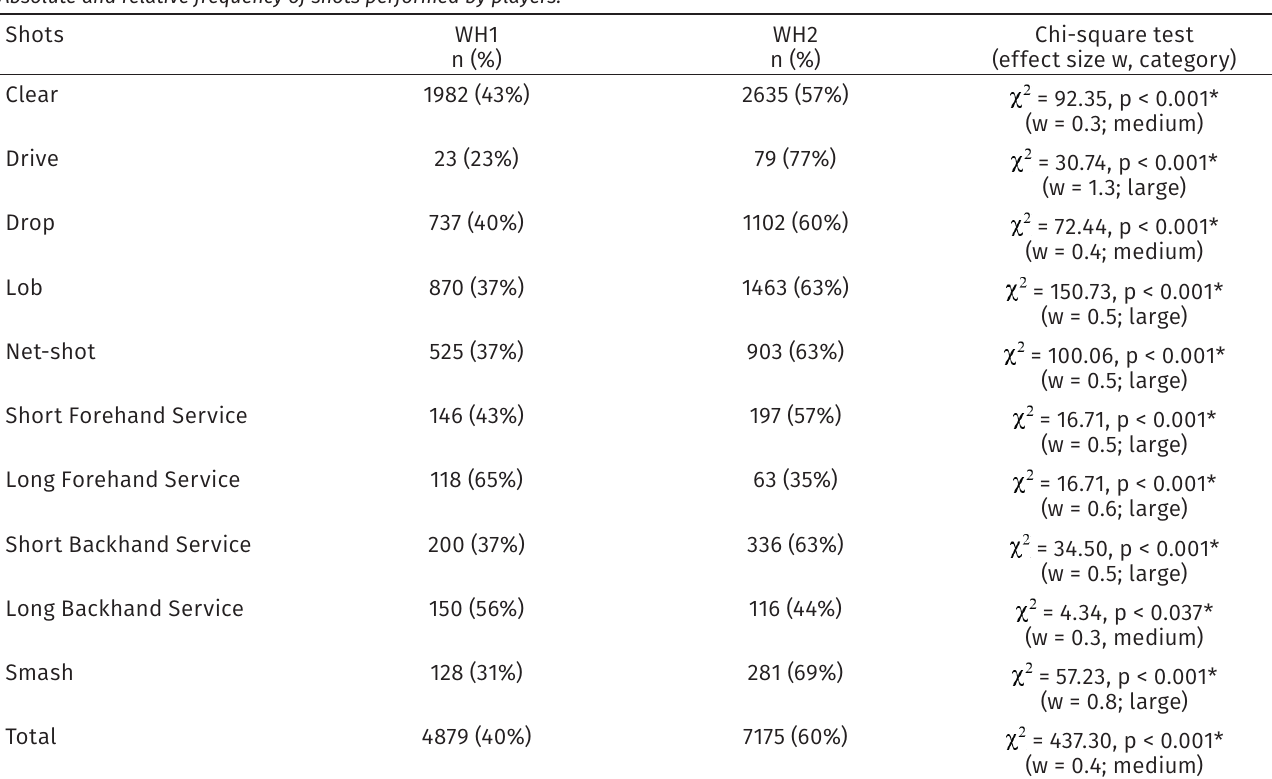
Table 2. Absolute and relative frequency of shots performed by players. Shots WH1